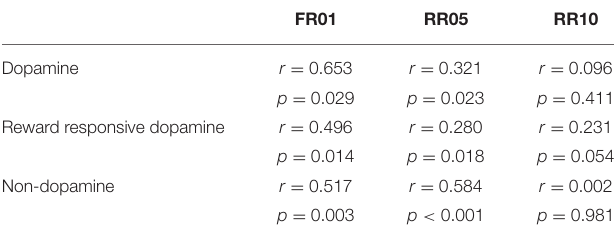
TABLE 3 | Table depicts the correlation between cue onset and reward delivery evoked